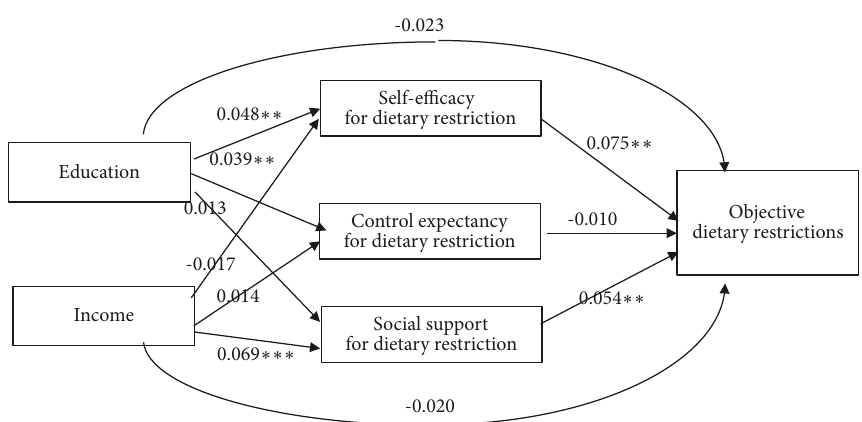
Figure 2: Direct and indirect effects of socioeconomicstatus on objective dietary restrictions as a function of psychosocial mediators. Note 1 : the effects of each variable were obtained after controlling for the influence of other variables without the variable in question. Note 2 : ∗ 𝑃 < .05, ∗∗ 𝑃 < .01, and ∗∗∗ 𝑃 < .001. Note 3 : total indirect influence of education on objective dietary restrictions (ODRs) through three